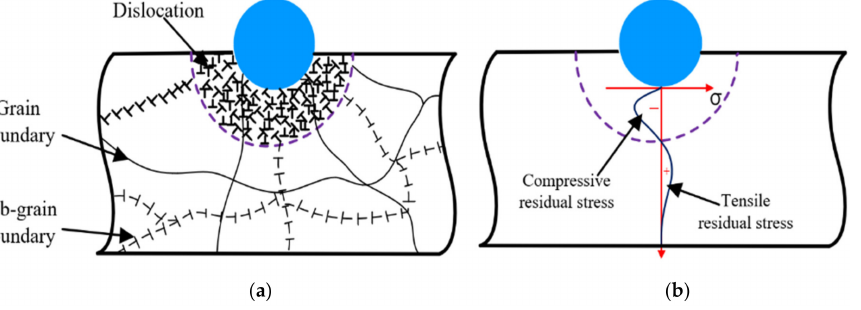
Figure 2. Schematic diagram of traditional shot peening process strengthening mechanism: ( a ) microstructure strengthening; ( b ) stress strengthening [23].